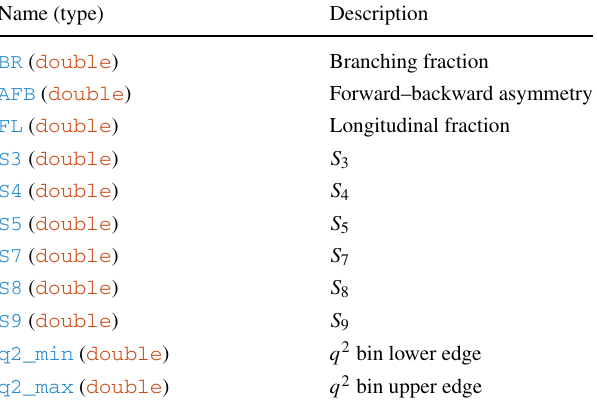
Table 4 Observables contained in the Flav_KstarMuMu_obs